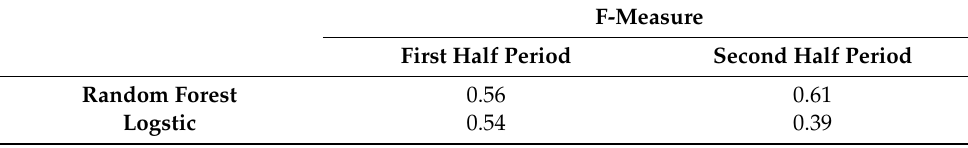
Table 5. Prediction accuracy of RV in the first half period and second-half period.